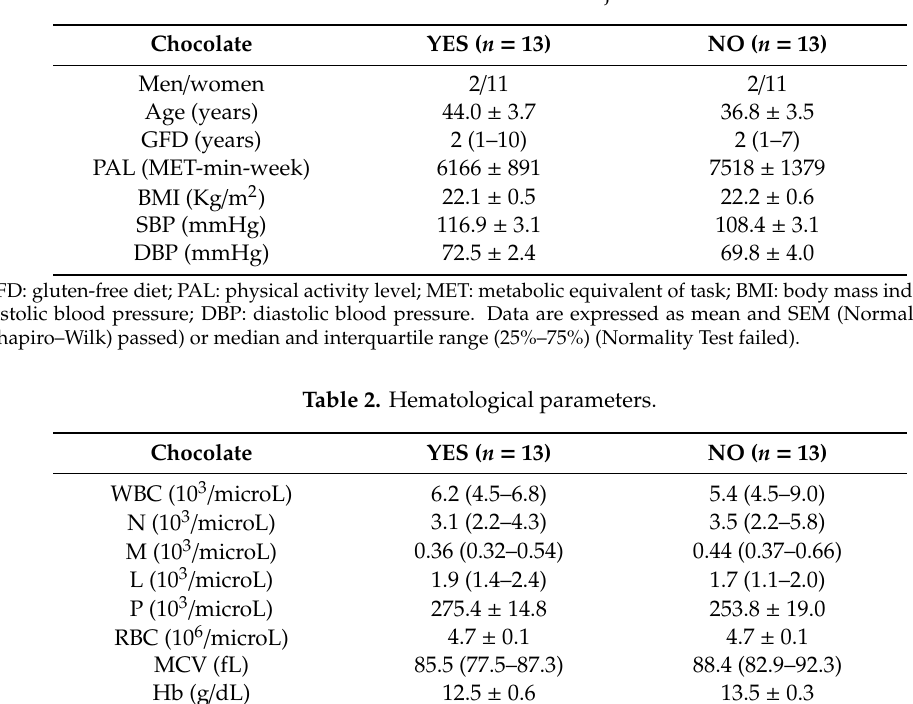
Table 1. Characteristics of subjects.